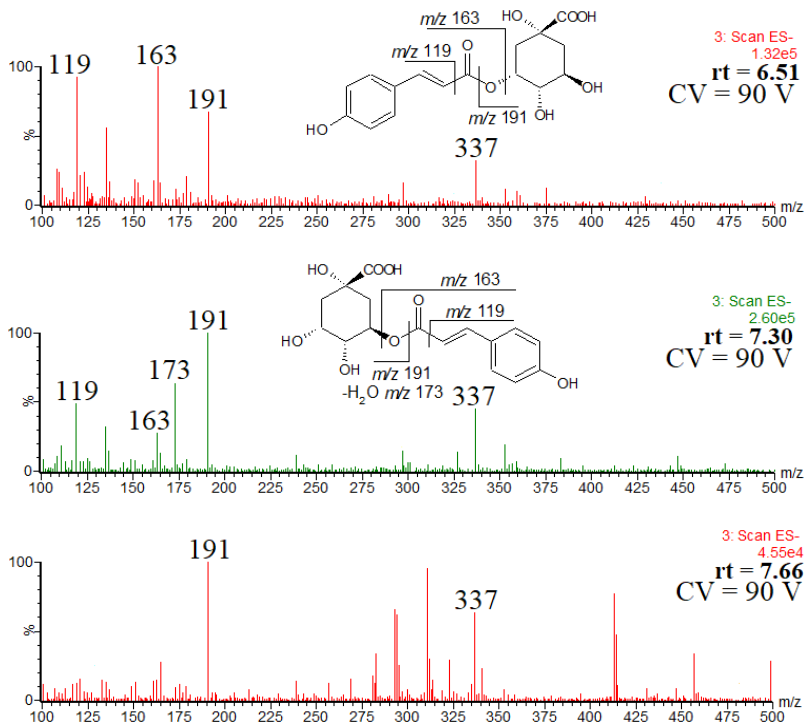
Figure 6. ESI mass spectra of coumaroylquinic acid isomers, and the observed fragmentation patterns of the two main isomers.